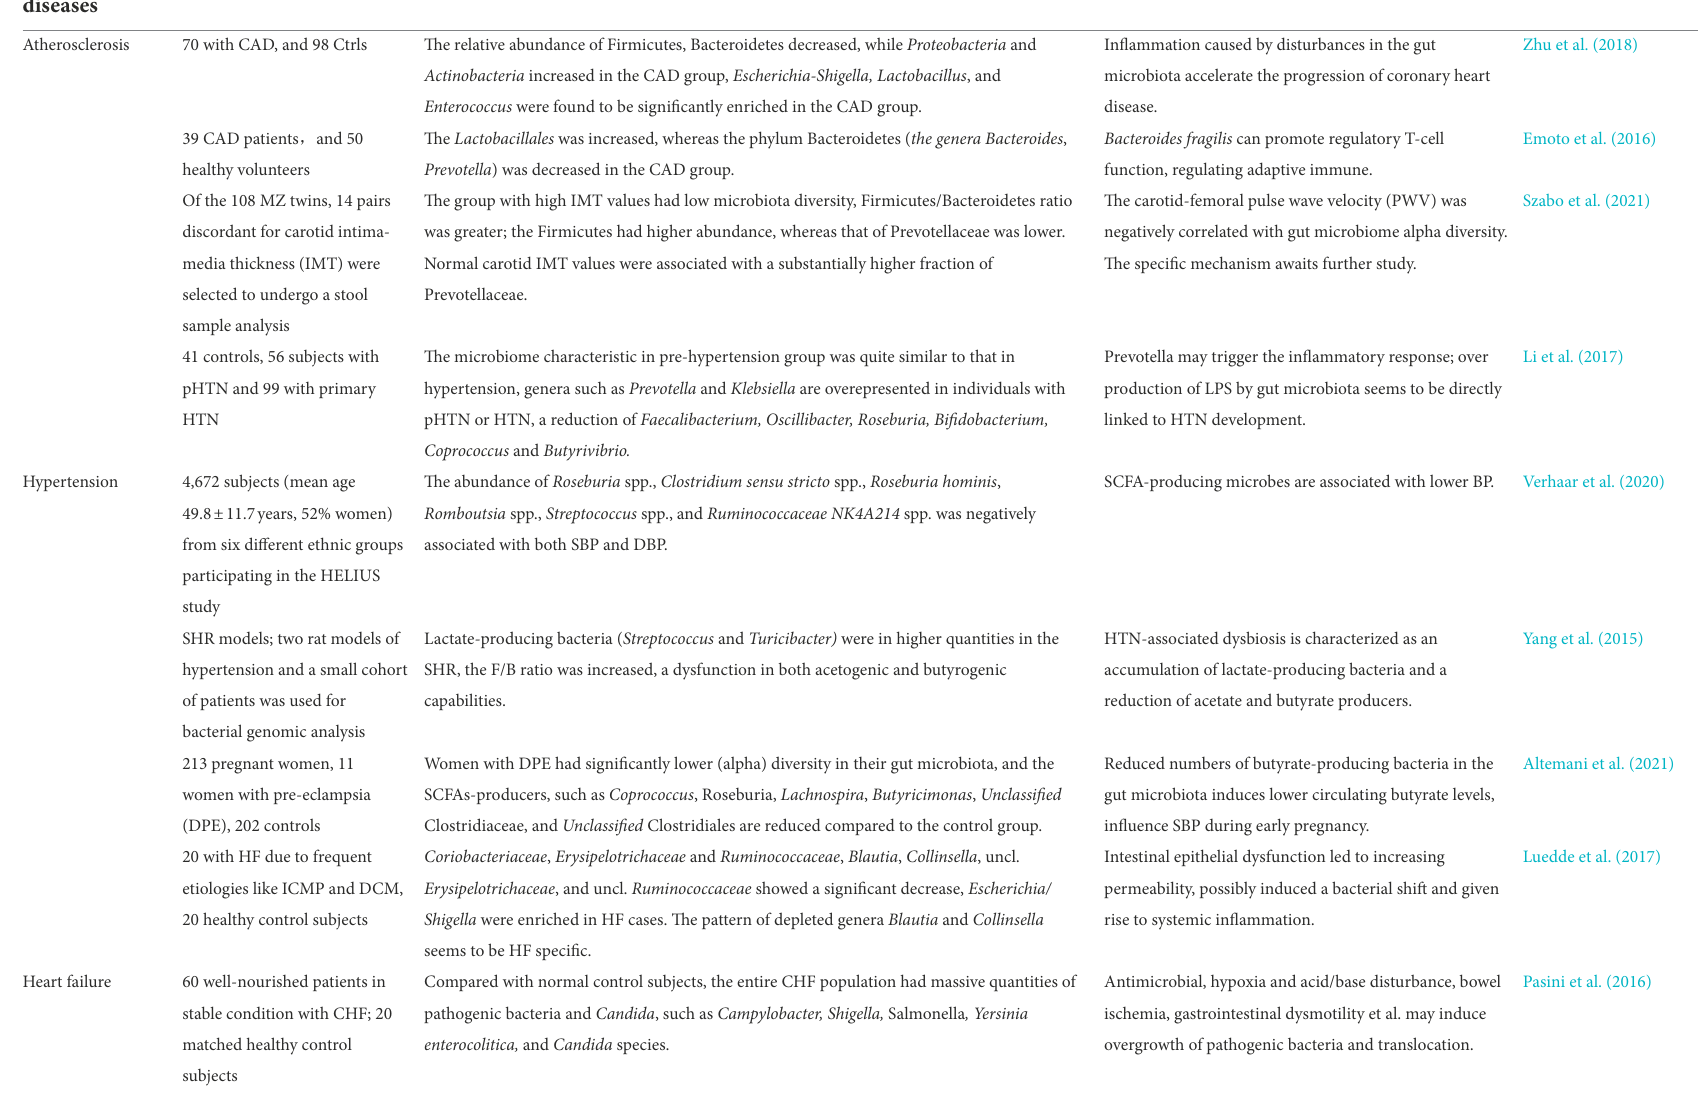
TABLE 1 Changes and characteristics of the gut microbiota in patients with three common